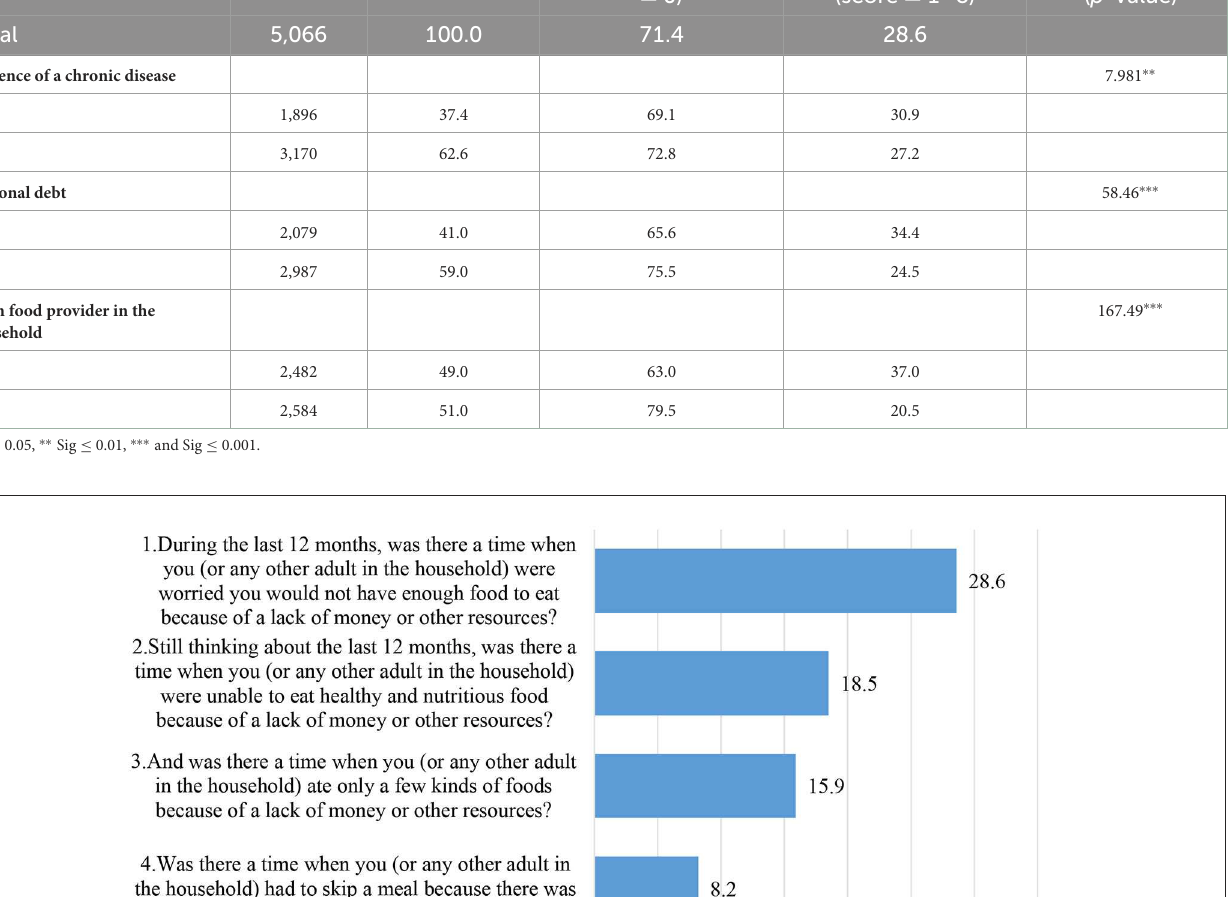
estimation of Bank of Thailand (30). This variable reflects the impact of debt burden on household consumption during the COVID-19pandemic. Debt was coded as “ yes ” (in debt), and “ no ” (without